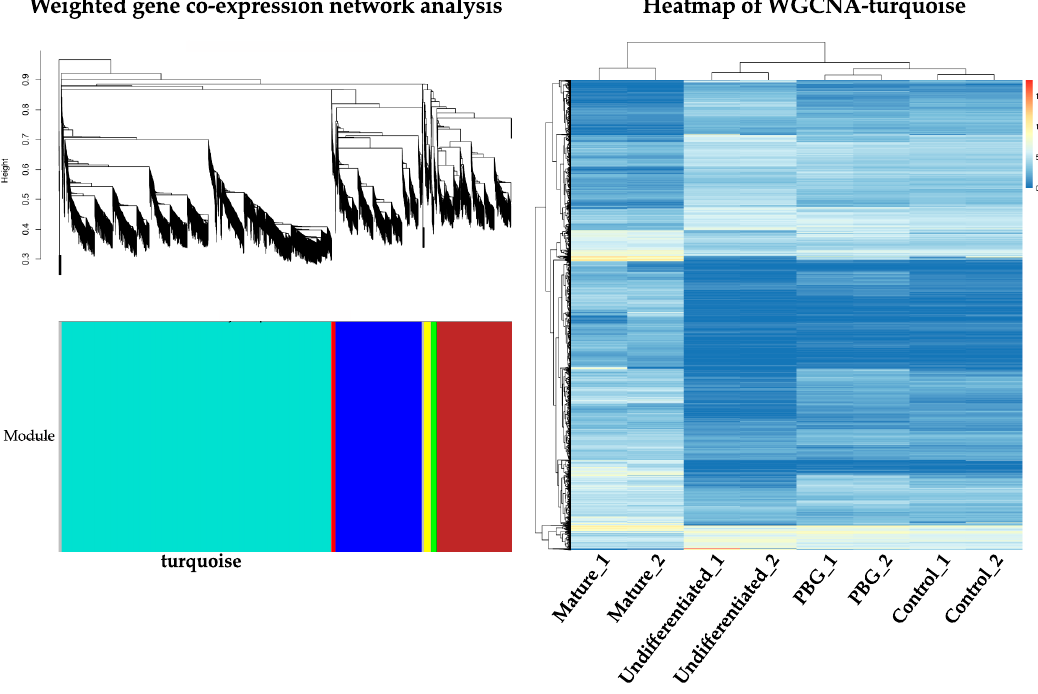
Figure 6. Weighted gene co-expression network analysis (WGCNA) analysis of correlation patterns